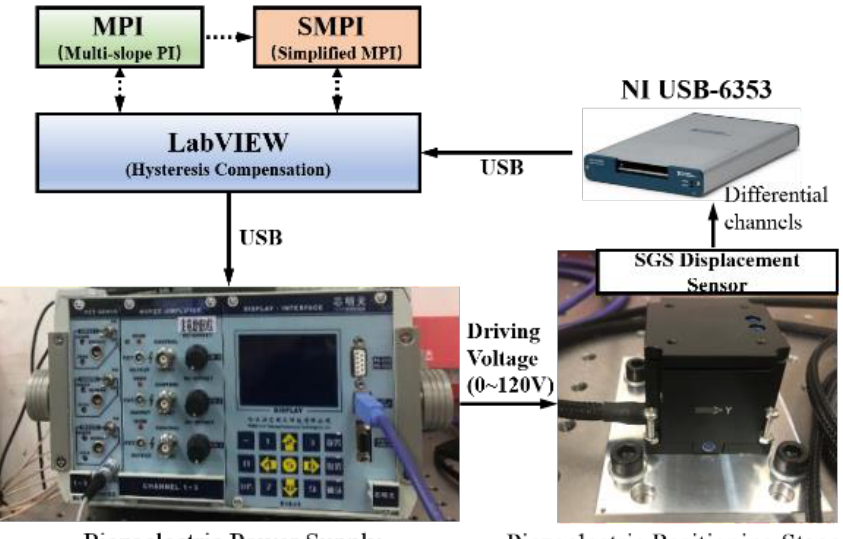
Figure 1. Experimental system.